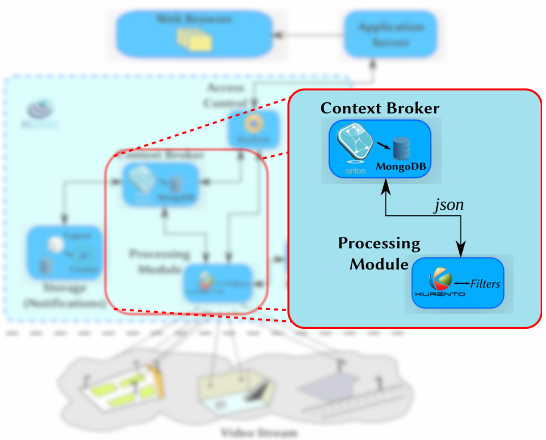
Figure 5. Processing module and OCB communication through JSON